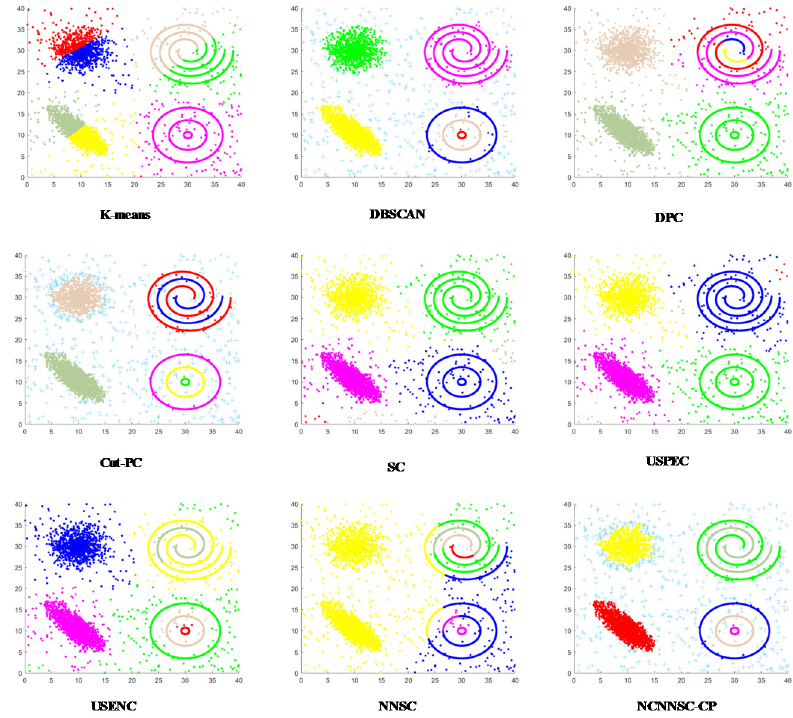
Figure 13. The results of 9 clustering algorithms in D8.